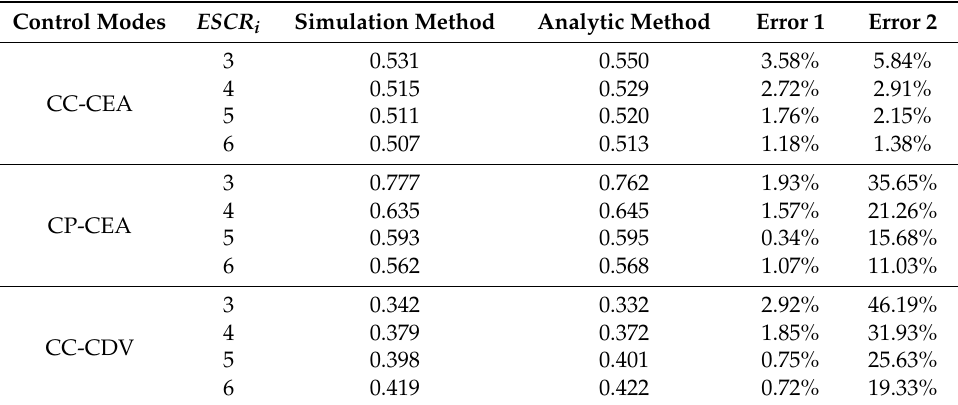
Table 2. Comparison of MIIF obtained from three